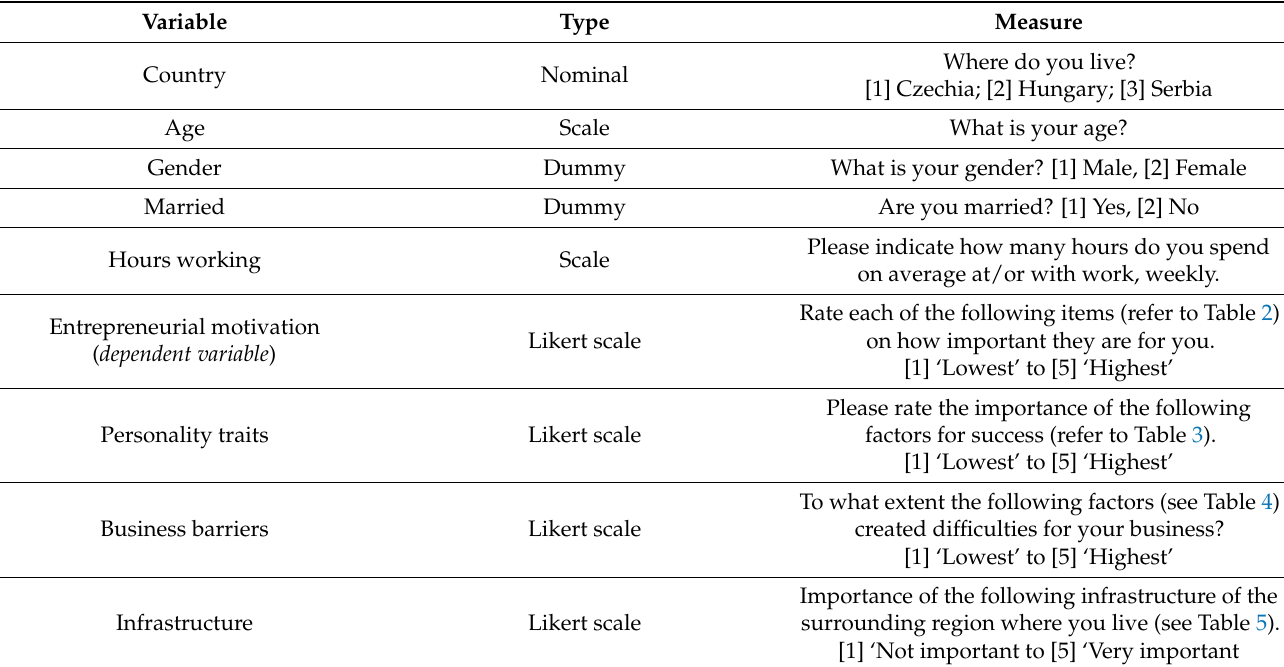
Table 1. Variable measurement.